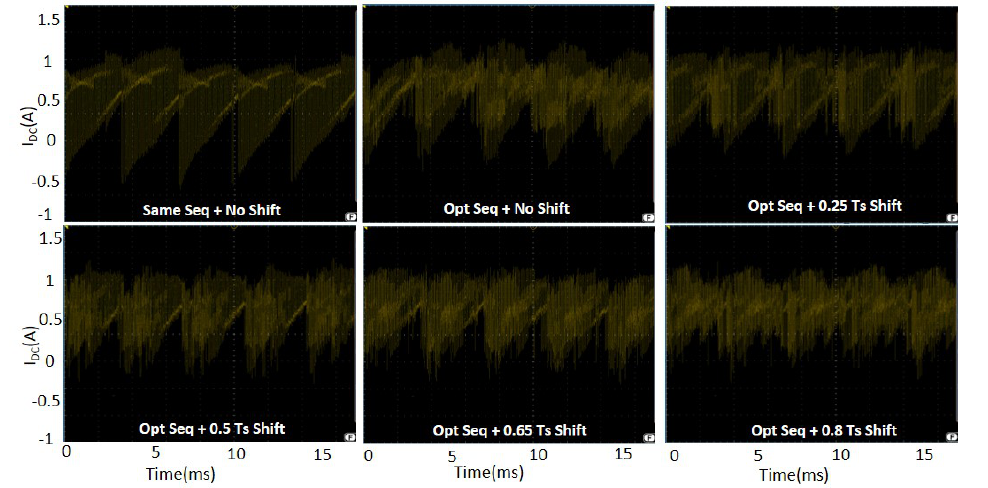
Figure 19. Experimental DC − link current for sequence + time-shifted interleaving at 60 ◦ pf angle.